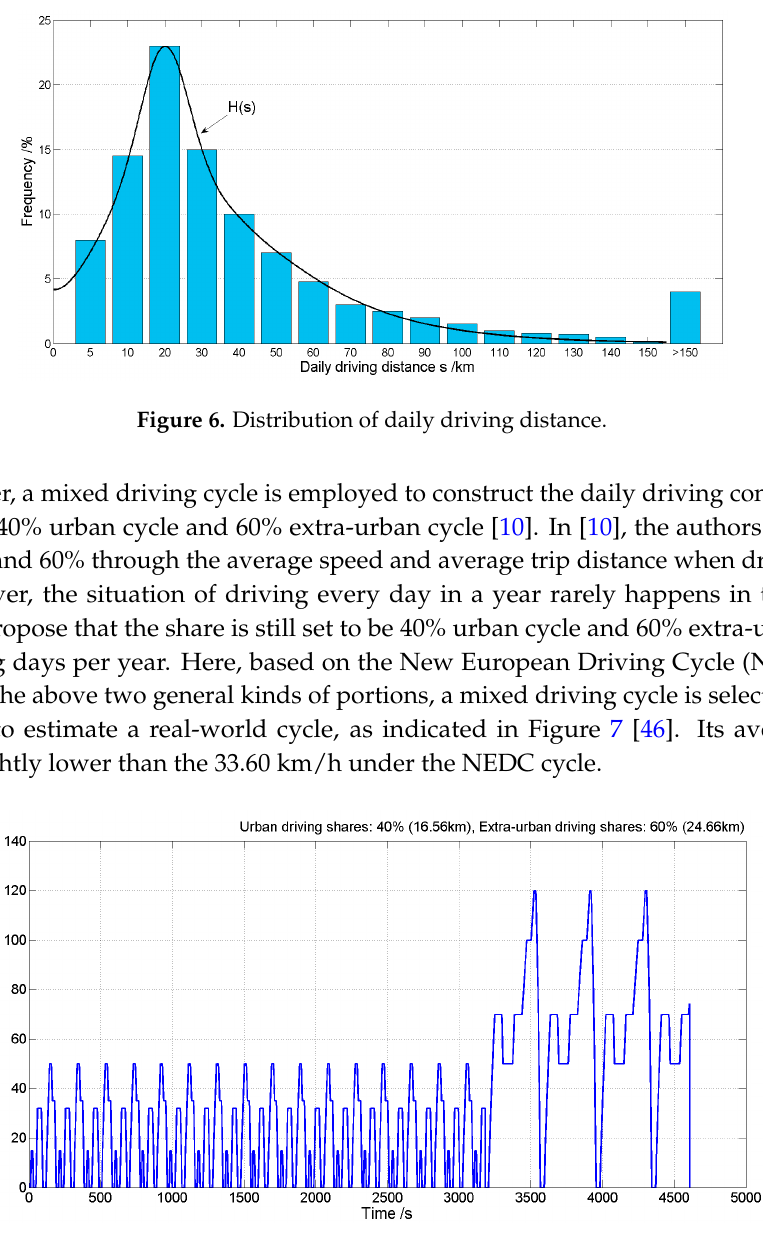
Figure 7. The mixture cycle based on NEDC.